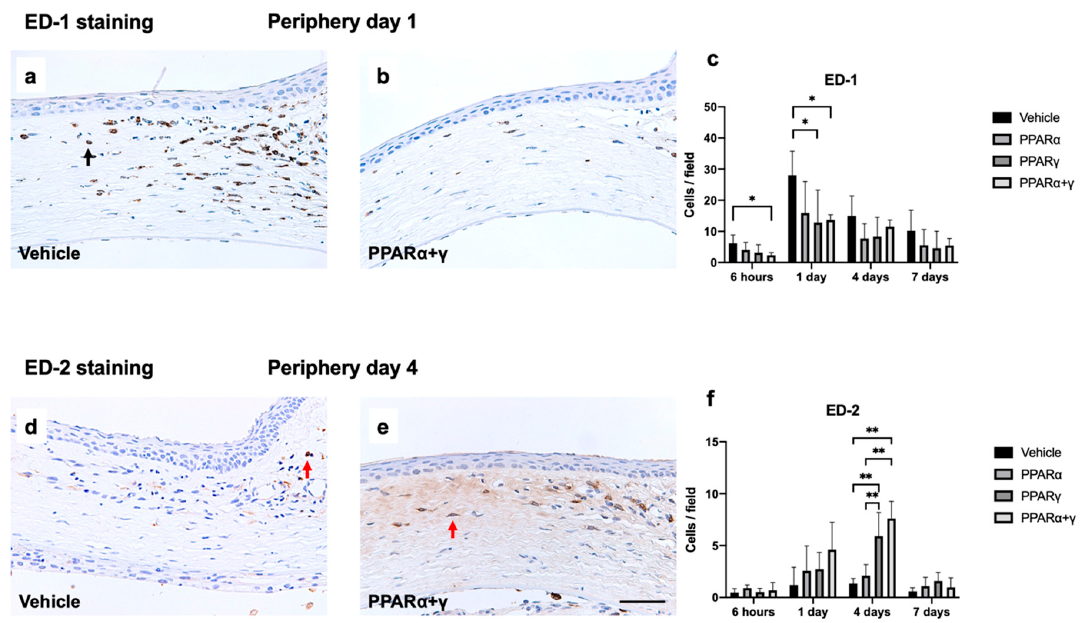
Figure 7. Infiltration of macrophages in the cornea after alkali injury. Representative photomicrographs of infiltrating macrophages in the corneal limbus after instillation of the vehicle ( a ) and PPAR α + γ ( b ) on day 1 showed prominent infiltration of ED-1-positive macrophages on day 1 in the vehicle group, but significantly suppressed infiltration in the PPAR α + γ group ( c ). Black arrow indicates an ED-1-positive cell ( a ). PPAR γ and PPAR α + γ treatment significantly suppressed ED-1-positive macrophages on day 1 compared with vehicle treatment ( c ). Data are presented as the mean ± standard error ( n = 8 samples / group). * p < 0.05. Although few ED-2-positive M2 macrophages were present in the peripheral cornea on day 4 after alkali burn in the vehicle group ( d ), PPAR α + γ treatment upregulated M2 macrophages ( e ). Red arrows indicate ED-2-positive cells ( d ), ( e ). Bar chart of the number of ED-2-positive cells shows a statistically significant di ff erence between the vehicle and PPAR γ groups, similar to the PPAR α + γ instillation group ( f ). Bar, 50 µ m ( a ), ( b ), ( d ), ( e ). Data are presented as the mean ± standard error ( n = 8 samples / group). ** p < 0.01, * p < 0.05.